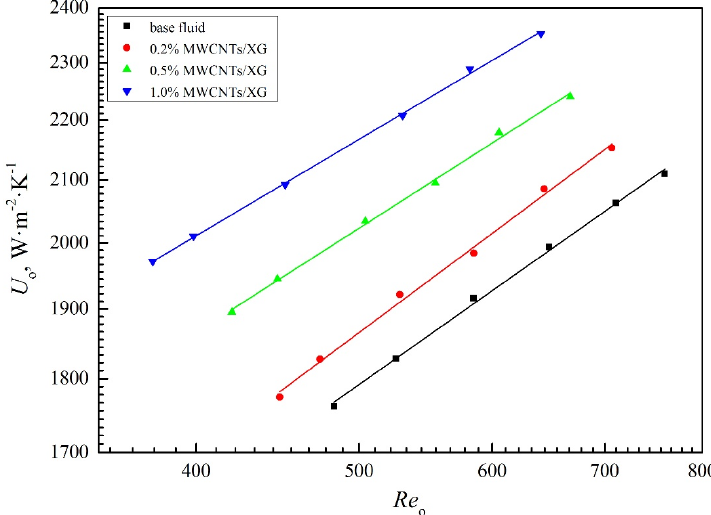
Figure 6. Overall heat transfer coef fi cient versus shell ‐ side Reynolds number.